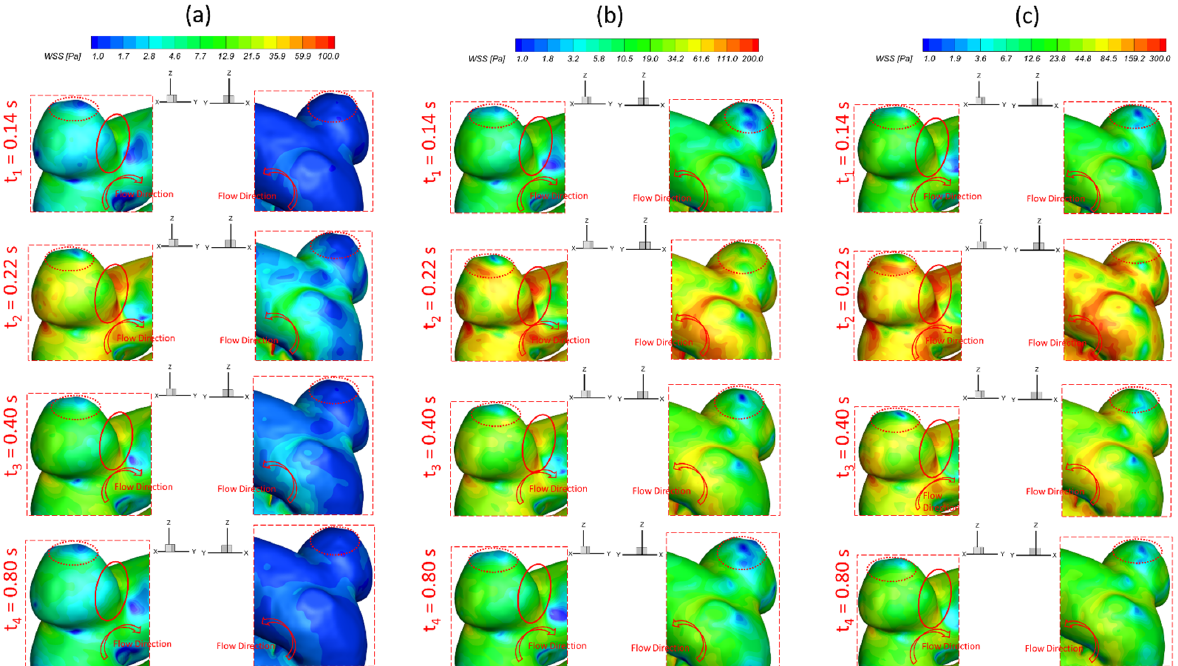
Figure 4. Visualized instantaneous WSS distributions on selected region (R1) of ICASA − 1 model at selected instants and shunt ratio of q A1 :q A2 = 75:25 under corresponded PFRs: ( a ) PFR−I, ( b ) PFR−II, and ( c ) PFR−III.